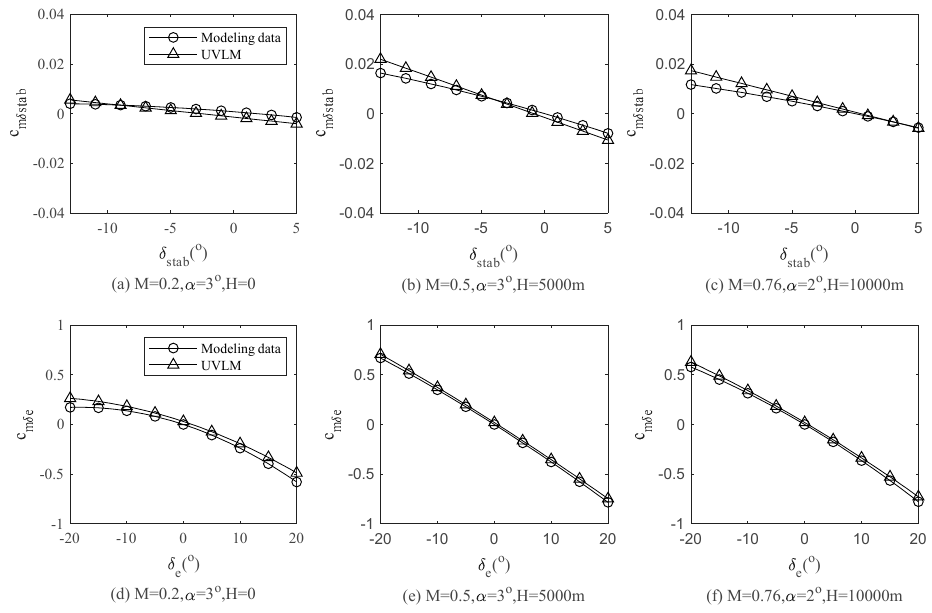
Figure 6. Comparison of computation and experimental pitching moment coefficients. ( a ) M = 0.2, α = 3°, H = 0; ( b ) M = 0.5, α = 3°, H = 5000 m; ( c ) M = 0.76, α = 2°, H = 10000; ( d ) M = 0.2, α = 3°, H = 0; ( e ) M = 0.5, α = 3°, H = 5000; ( f ) M = 0.76, α = 2°, H = 10000.